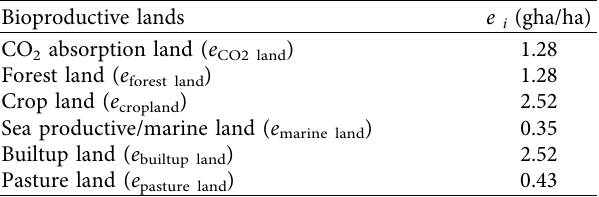
i ) of bioproductive lands [38].